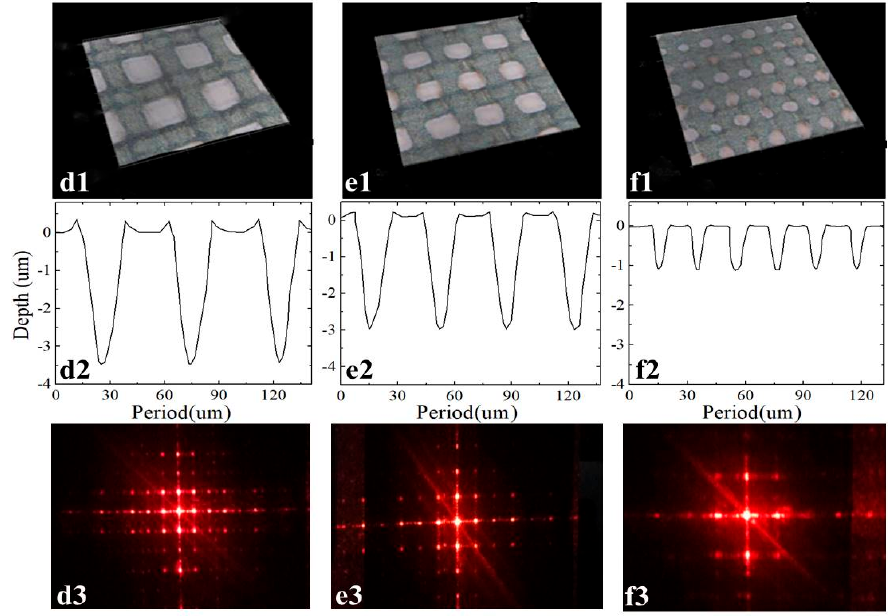
Figure 5. The laser energy was 8.26 mJ/cm 2 , the scanning speed were 1, 2 and 5 mm/s, and the corresponding period were 48, 35 and 20 μ m single gratings ( a – c ) and composite gratings ( d – f ). ( a1 – f1 ) were the pattern of optical microscope, ( a2 – f2 ) were the step meter profile, and ( a3 – f3 ) were the grating diffraction pattern.